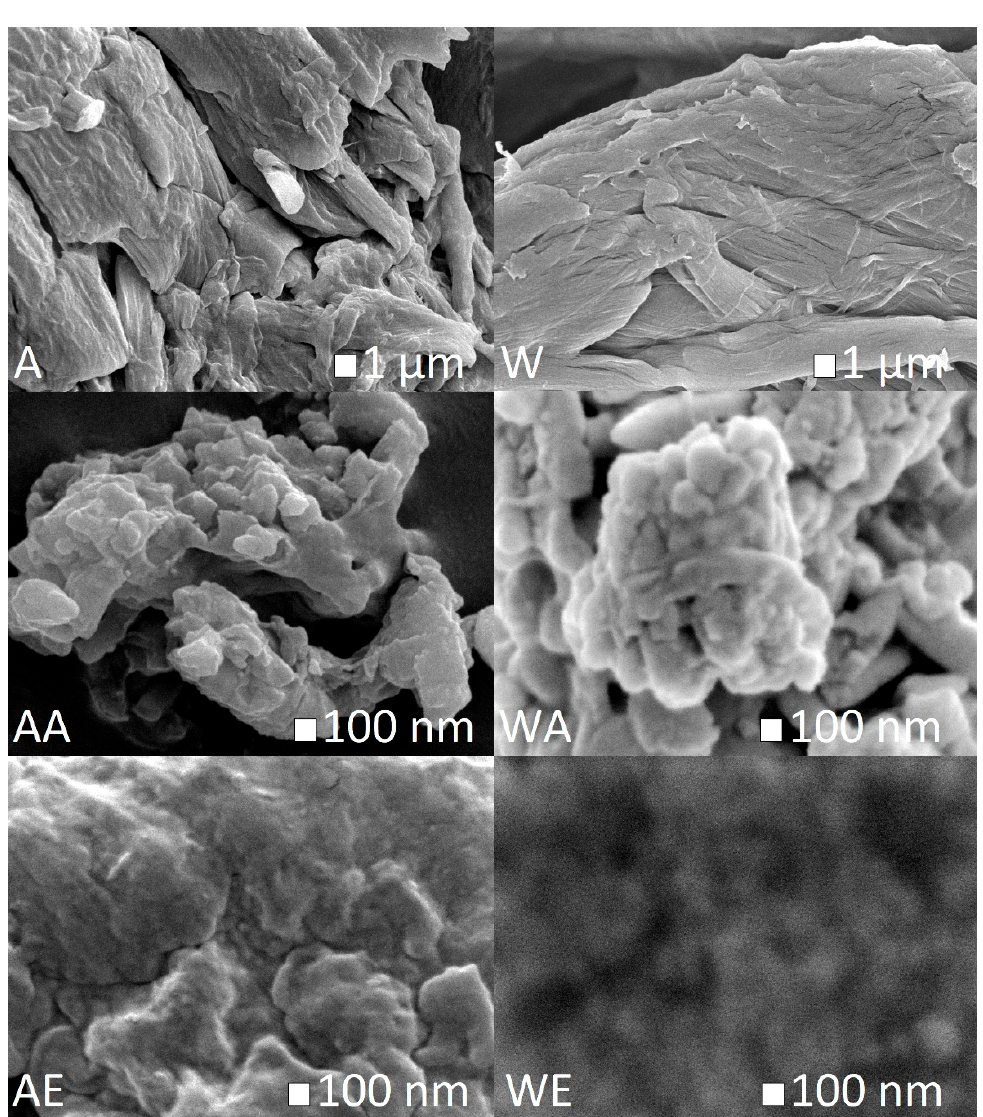
Figure 4. SEM images of ( A ) enzyme-pretreated Avicel cellulose, ( AA ) enzyme-pretreated Avicel cellulose treated with AmimCl, ( AE ) enzyme-pretreated Avicel cellulose treated with EmimOAc, ( W ) enzyme-pretreated Whatman cellulose, ( WA ) enzyme-pretreated Whatman cellulose treated with AmimCl, and ( WE ) enzyme-pretreated Whatman cellulose treated with EmimOAc.